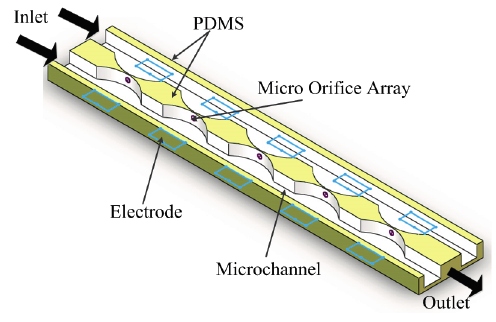
Figure 6. Schematic diagram of electrofusion chip designed by